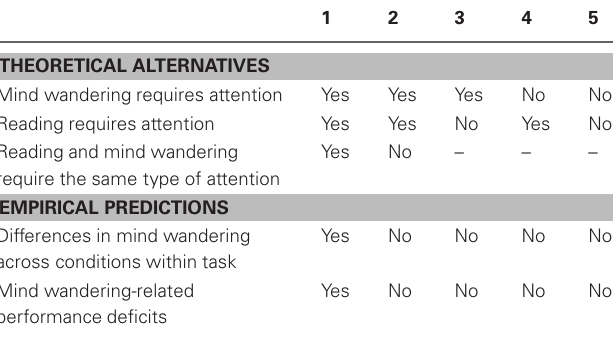
Table 1 | A representation of the theoretical relations between attention, reading and mind wandering, and the empirical predictions that follow from these alternatives with regards to whether differences in mind wandering across condition should be observed and whether mind wandering-related performance deficits should be